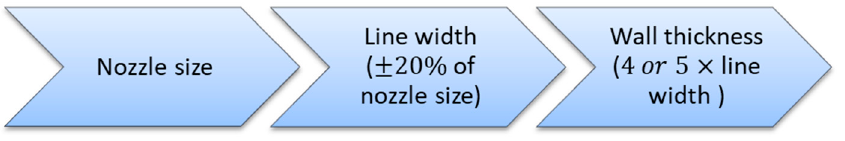
Figure 17. Methodology used to reduce wall thickness ensuring air tightness.